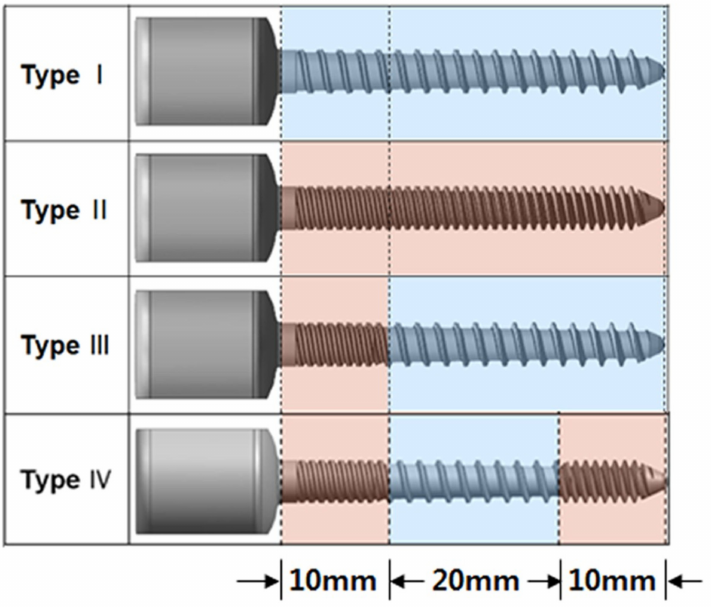
Figure 1. Illustration of four types of screws with di ff erent thread